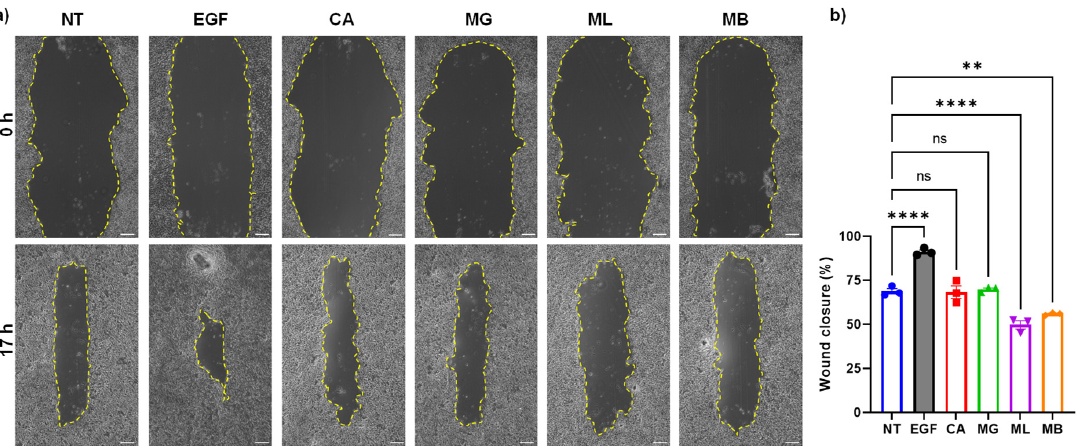
Figure 3. Effect of pore-forming peptides on keratinocyte cell migration. ( a ) Photographs showing the effect of peptides on the migration of NTLG1 cells that were treated with CA (2.0 μ M), MG (3.32 μ M), ML (2.82 μ M), MB (4.96 μ M), epidermal growth factor (EGF, 3.1 nM), or untreated (NT). Yellow dotted lines indicate the border of wounds at the indicated timepoint with 4× magnification. Scale bar = 100 μ m. ( b ) Quantification of wound closure after 17 h post-addition of peptides or EGF. The data are expressed as mean ± SEM ( n = 3; ns, non-significant ** p < 0.01, **** p < 0.0001).